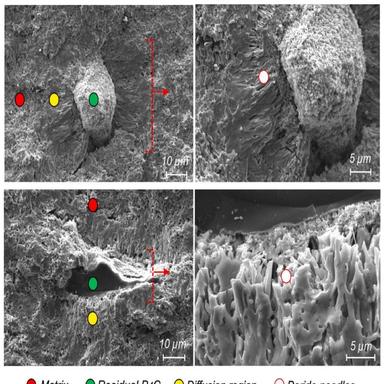
Morphologies of the diffusion zones formed around the residual B4C particles.